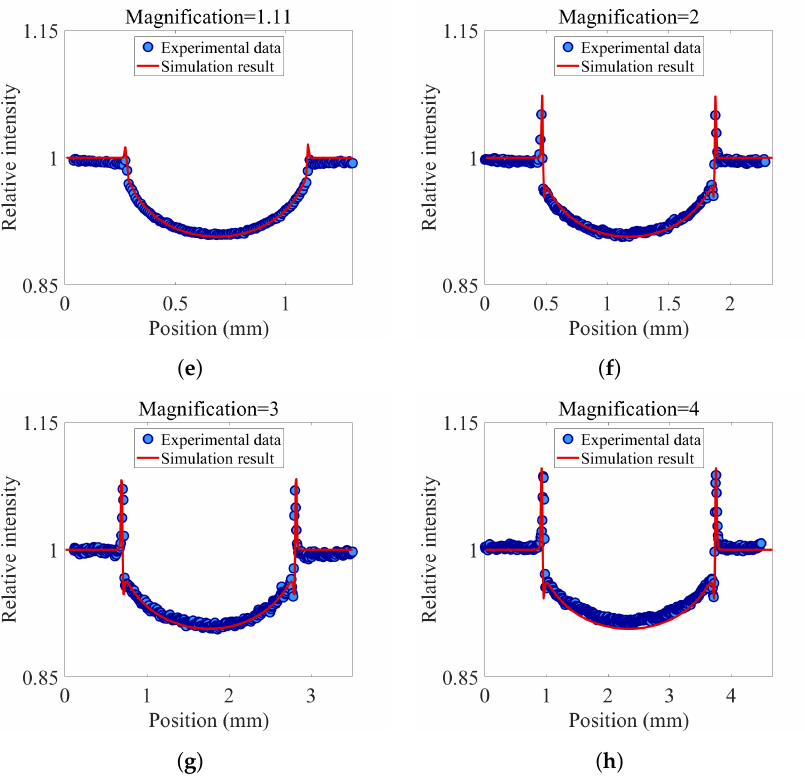
Figure 14. Edge-enhancement effect of PB-XPCi for a 0.7 mm PTFE rod at different magnifications from 1.1 to 4.